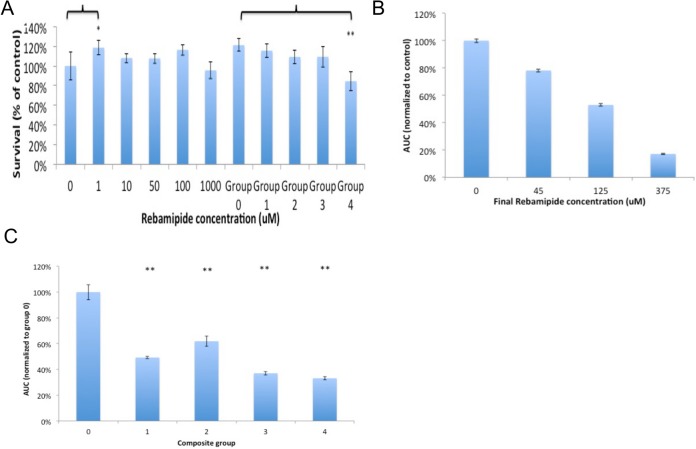
Macrophage viability and ROS production.Rebamipide does not significantly reduce the viability of macrophages up to 1mM (A). The leach product from group 4 composites was slightly toxic, but the difference in viability, compared to controls, was not statistically significant. Rebamipide quenches ROS in a dose dependent manner (B), with an estimated EC50 of 400uM in Raw 264.7 macrophages. Rebamipide, present in the leach from each composite group, was an effective quencher of ROS (C). (* indicate p< 0.05, ** indicate P<0.01 when compared to untreated, or group 0 for leach, Dunnet’s t-test).